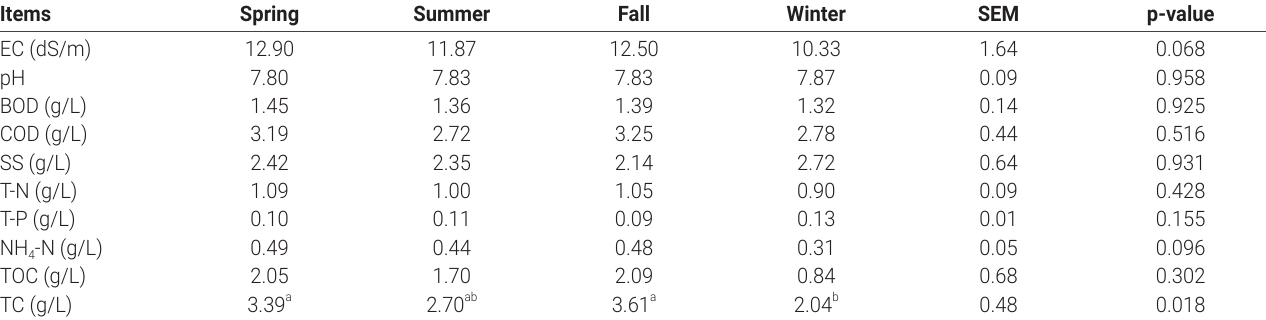
Table 2. Chemical properties of aerated liquid manure recirculating in the pit of swine barn (seasonal) Items Spring